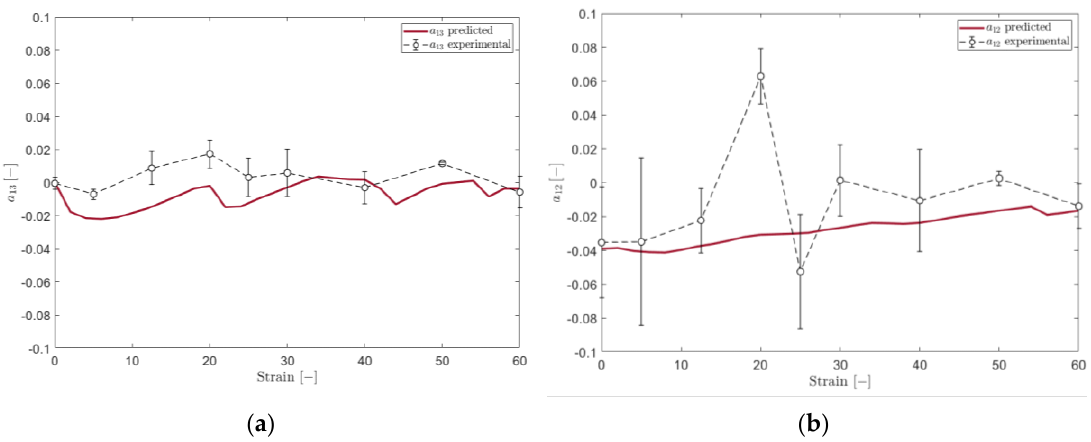
Figure 12. Experimental (black) and predicted (red) off-diagonal orientation components ( a ) a 12 and ( b ) a 13 as a function of shear strain. ( b ) a 13 as a function of shear